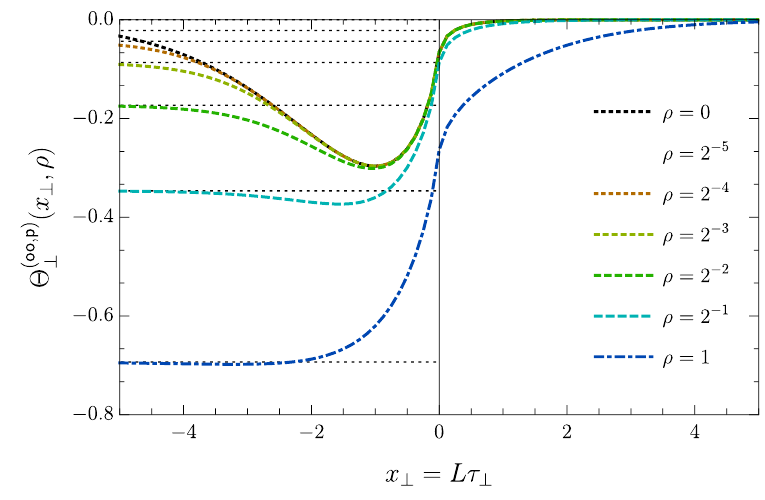
( oo , p ) ( x ρ ) for different values of the aspect ratio ⊥ , ⊥